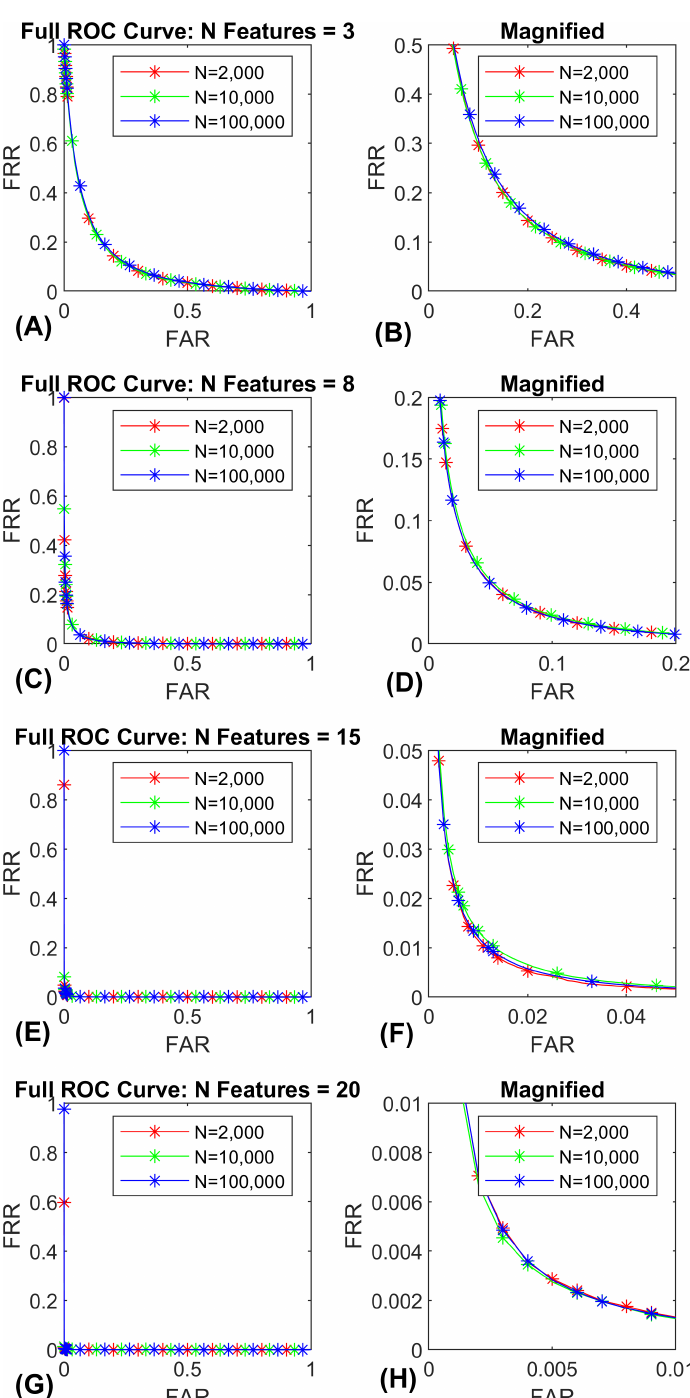
Figure 9. ROC-curves for synthetic data (Band 8). Curves for 3, 8, 15 and 20 features. Each curve was evaluated at gallery sizes of 2000, 10,000 and 100,000 subjects. Each curve is the average over 30 repetitions. ( A ) illustrates the entire 3 ROC-curves for 3 features. ( B ) illustrates the same data in ( A ) zoomed in on the lower error rates for enhanced visibility. ( C ) illustrates the entire 3 ROC-curves for 8 features. ( D ) illustrates the same data in ( C ) zoomed in on the lower error rates for enhanced visibility. ( E ) illustrates the entire 3 ROC-curves for 15 features. ( F ) illustrates the same data in ( E ) zoomed in on the lower error rates for enhanced visibility. ( G ) illustrates the entire 3 ROC-curves for 20 features. ( H ) illustrates the same data in ( G ) zoomed in on the lower error rates for enhanced visibility. Note that the ROC-curves are essentially overlapping across gallery